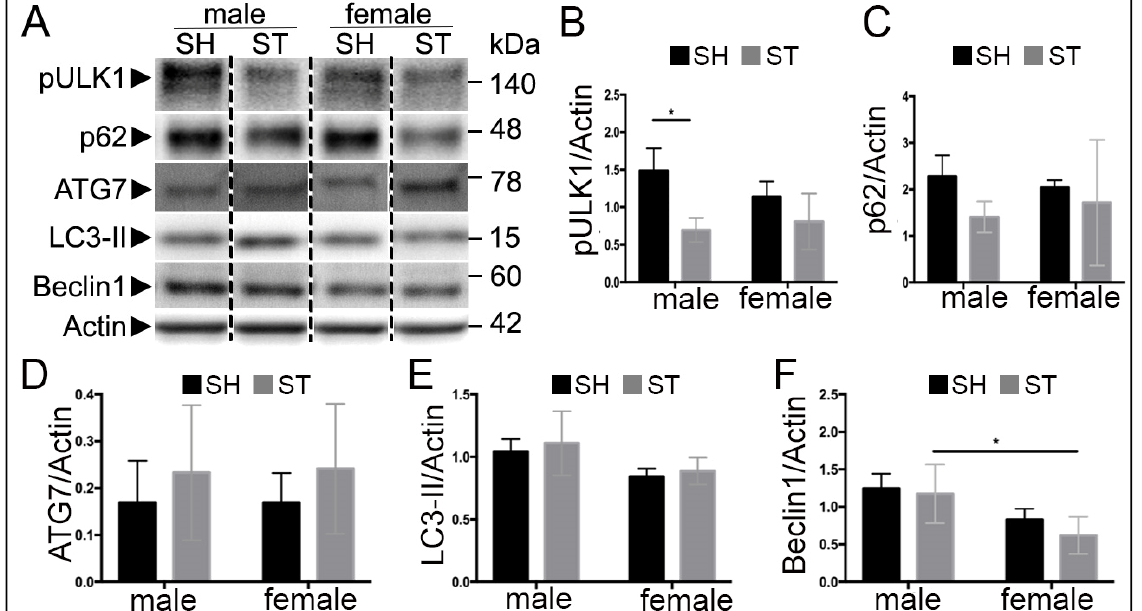
Figure 2. Autophagy proteins 6 h after ischemia. ( A ) Representative Western blots of Beclin1, pULK, LC3, and ATG7. ( B ) Quantification of pULK1. An effect of stroke was observed, ( p = 0.001) with lower levels of pULK1 observed in stroke males compared to sham. ( C , D ) No observable differences in levels of p62 and ATG7. ( E ) Quantification of LC3. An effect of sex was observed with males displaying increased levels, ( p = 0.01). ( F ) Quantification of Beclin1. An effect of sex was observed ( p = 0.003) with male strokes displaying higher levels compared to female strokes. * p < 0.05.